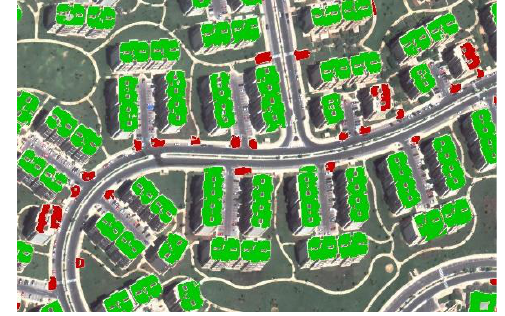
Figure 7 . Sample output after applying Support Vector